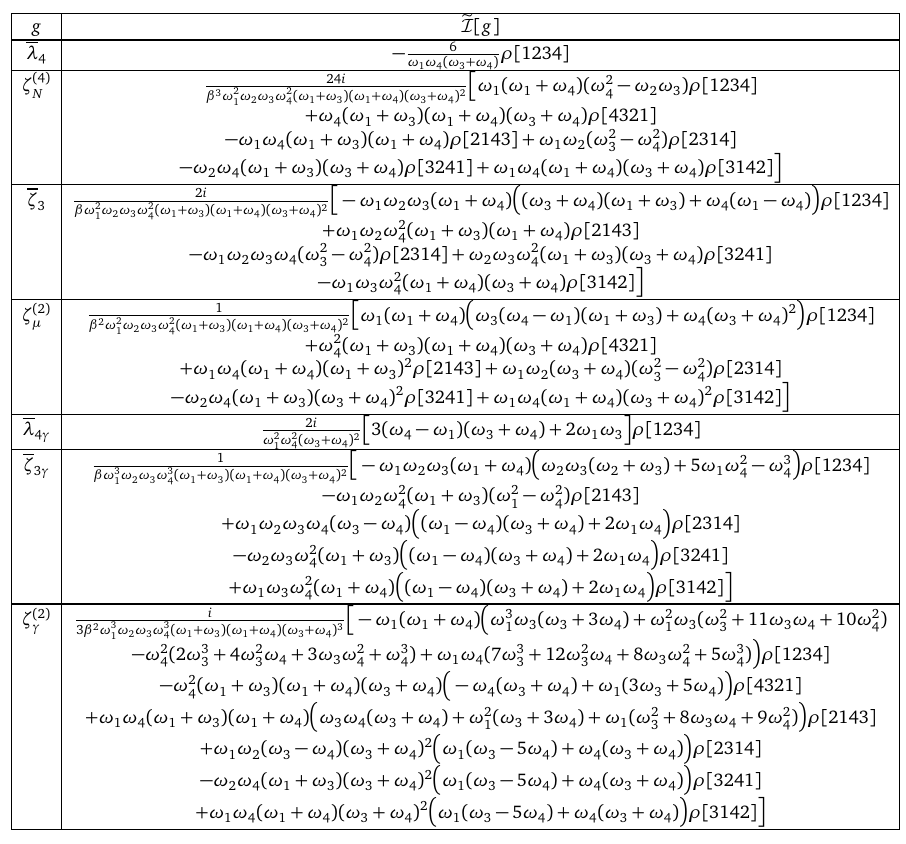
Table 7: SK couplings upto leading order in